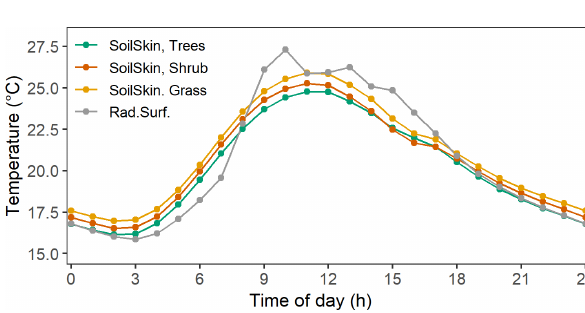
Figure 4. Diurnal summer (June to August) temperature cycles. Simulated soil skin temperature (SoilSkin, average of 20 best runs) for all vegetation types (trees, shrub and grass) and calculated ra- diative temperature (Rad.Surf.) from upward longwave radiation.